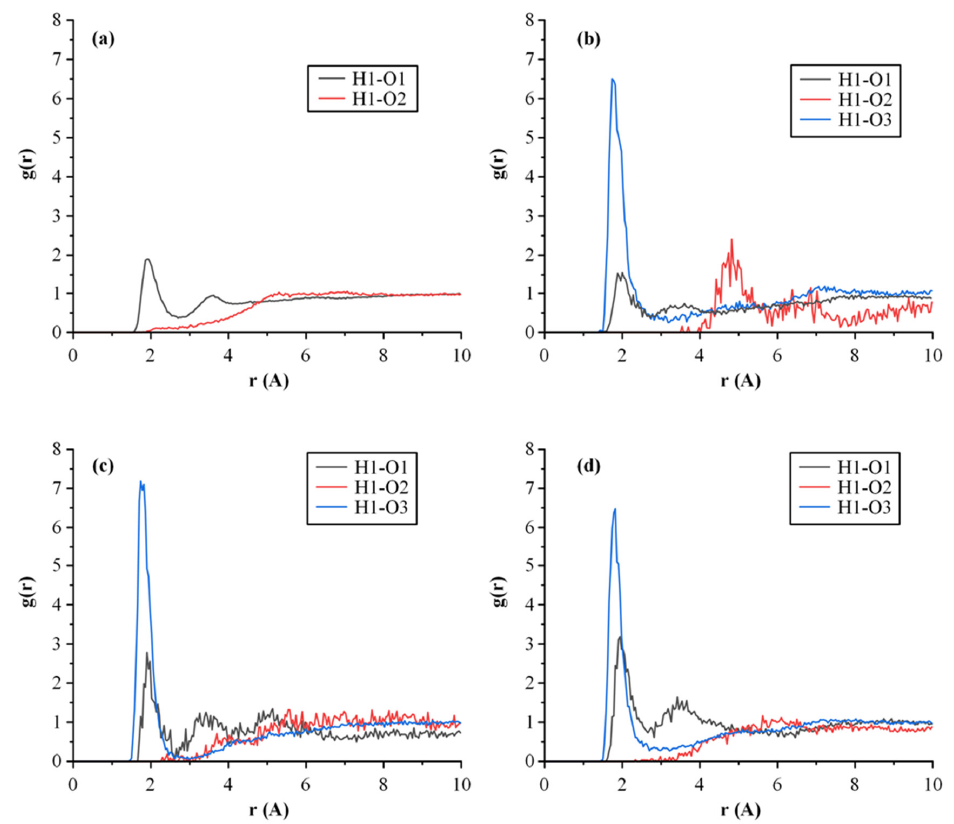
Figure 9. Radial distribution functions, g(r), of intermolecular interactions for the ( a ) amorphous LUT and the LUT–PVP ASDs at ( b ) 10/90, ( c ) 20/80, and ( d ) 70/30 drug-to-polymer-weight ratios. H1 = LUT’s hydroxyl protons; O1 = LUT’s hydroxyl oxygens; O2 = LUT’s ether oxygens; O3 = PVP’s ketone oxygens.